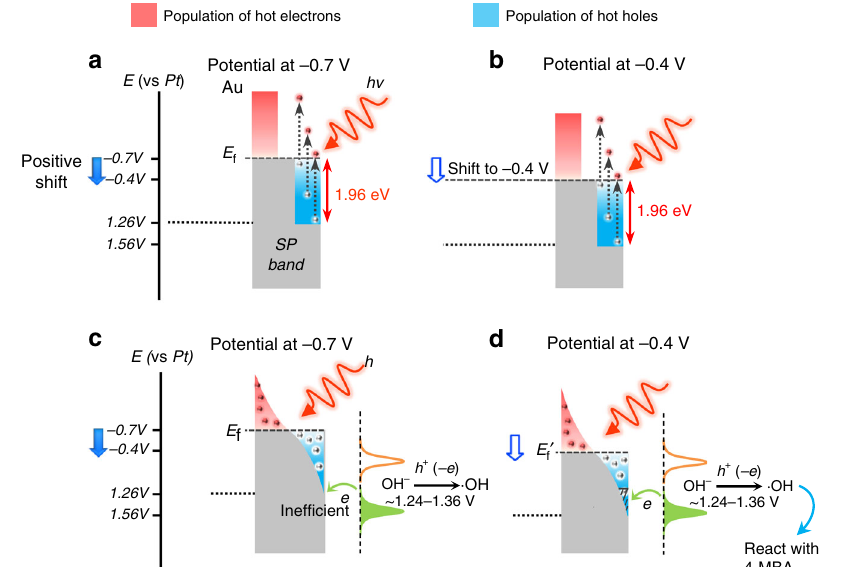
Fig. 3 Effect of potential on the carrier energy and the reaction. Panels a and b illustrate the excitation of the hot carriers, c and d illustrate the population of carriers after decaying to follow the Fermi – Dirac-like distribution. Panels a and c are the energy distributions of carriers at ‒ 0.7 V, b and d are the energy distributions of carriers at ‒ 0.4 V. (All potentials are referenced to a Pt electrode. The energy axis is not to scale for